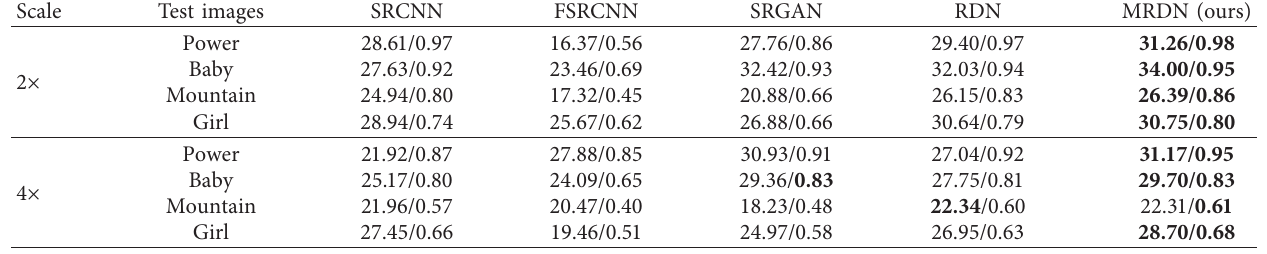
Figure 4: Super-resolution results of the power image with magnification factor 4: (a) original high-resolution image; (b) result reconstructed by SRCNN; (c) result reconstructed by FSRCNN; (d) result reconstructed by SRGAN; (e) result reconstructed by RDN; (f) result reconstructed by our method. Table 1: Evaluation index (PSNR/SSIM) of super-resolution results by different methods.